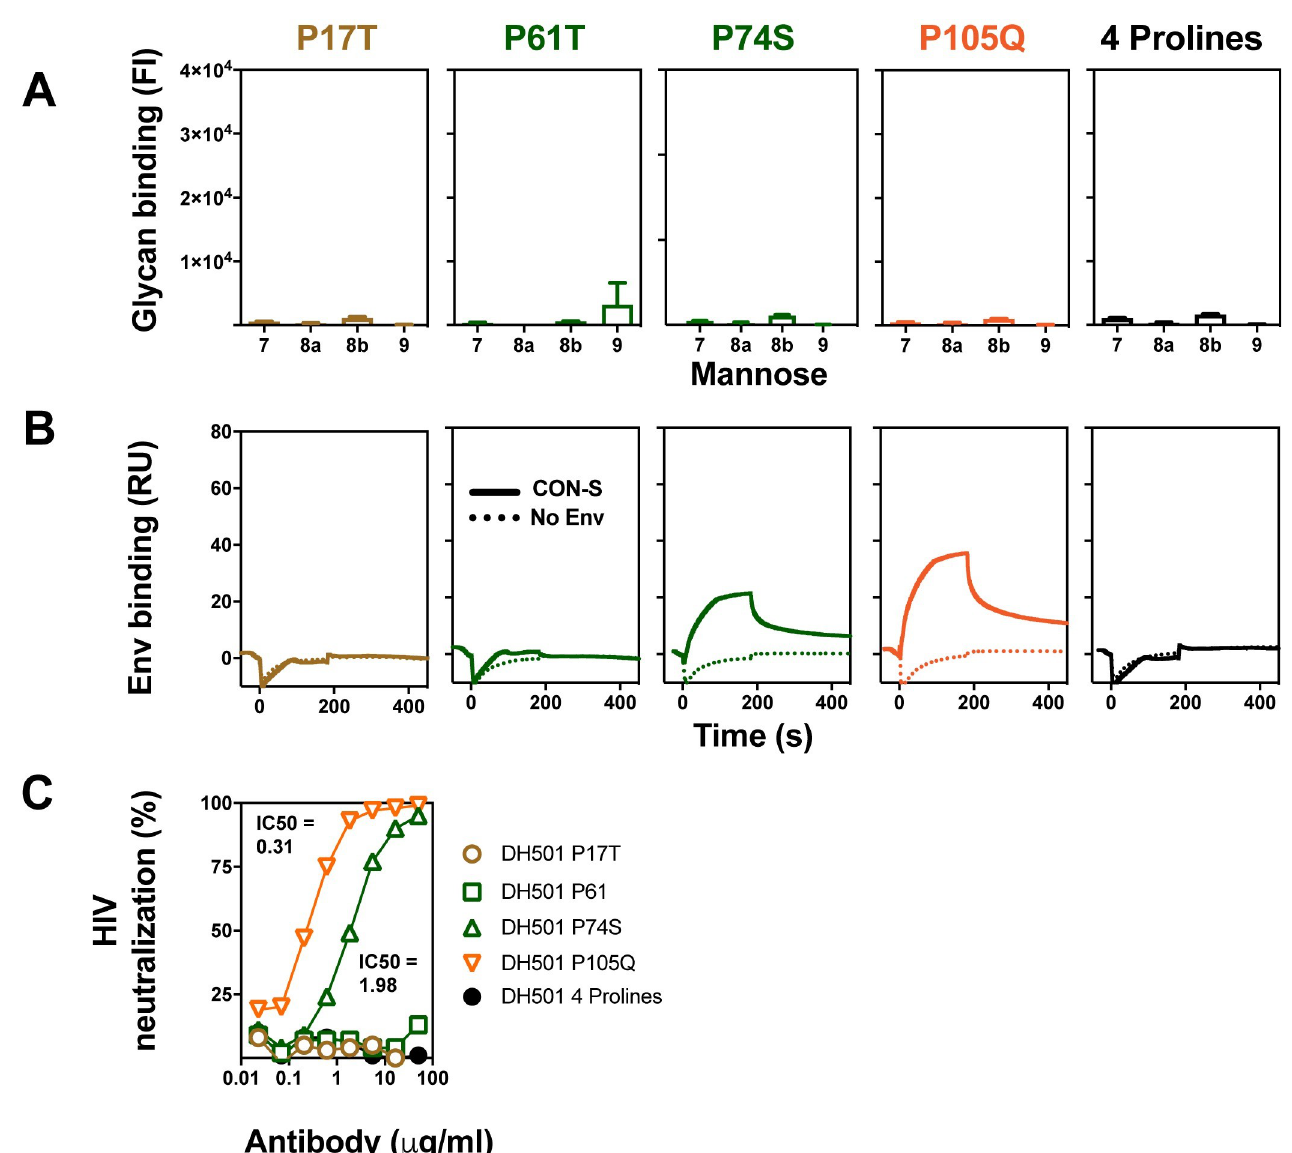
Fig 7. HFWR somatic mutations encode proline amino acids that are critical for antibody function. (A) High mannose glycan reactivity for DH501 IgG variants where framework region prolines were reverted to their germline-encoded amino acid. Prolines selected for reversion are indicated with diamonds in Fig 6A . Prolines were reverted individually, or all four prolines were reverted in the same antibody (4 prolines). Positive glycan binding based on negative control antibody binding is shown as a filled bar. Open bars indicate negative binding values. Positivity threshold for 7, 8a, 8b, and 9 was 0.18x10 4 for each glycan. DH501 H/UCA L which includes all four prolines was used as a positive control as shown in Fig 4 . ( B ) CON-S SOSIP binding by SPR for each of the DH501 proline revertants. Antibody binding to buffer without envelope is shown by a dotted line (No Env). ( C ) DH501 proline-revertant antibody neutralization of Man 9 GlcNAc 2 -enriched HIV-1 JR-FL infection of TZM-bl cells.